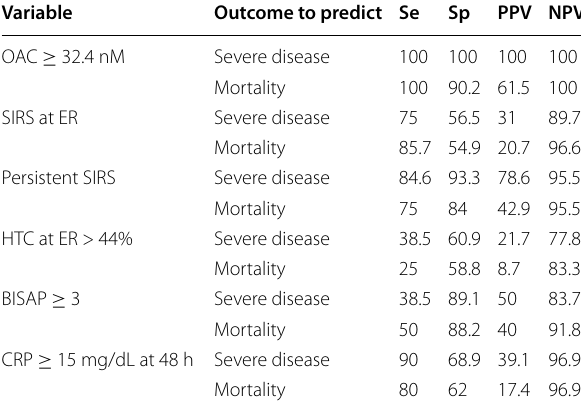
Se Sensitivity, SP specificity, PPV/NPV positive/negative predictive values, POF persistent organ failure, OAC oleic acid chlorohydrin, SIRS systemic